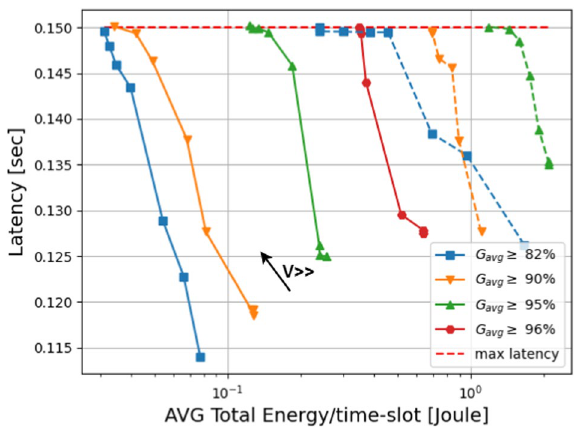
Fig. 3 Average energy versus average latency, for deep-CE (solid) and down-sampling (dashed). This figure makes a comparison of the trade-offs between the energy consumption of the overall system (UE obtained with the deep-CE and the down-sampling